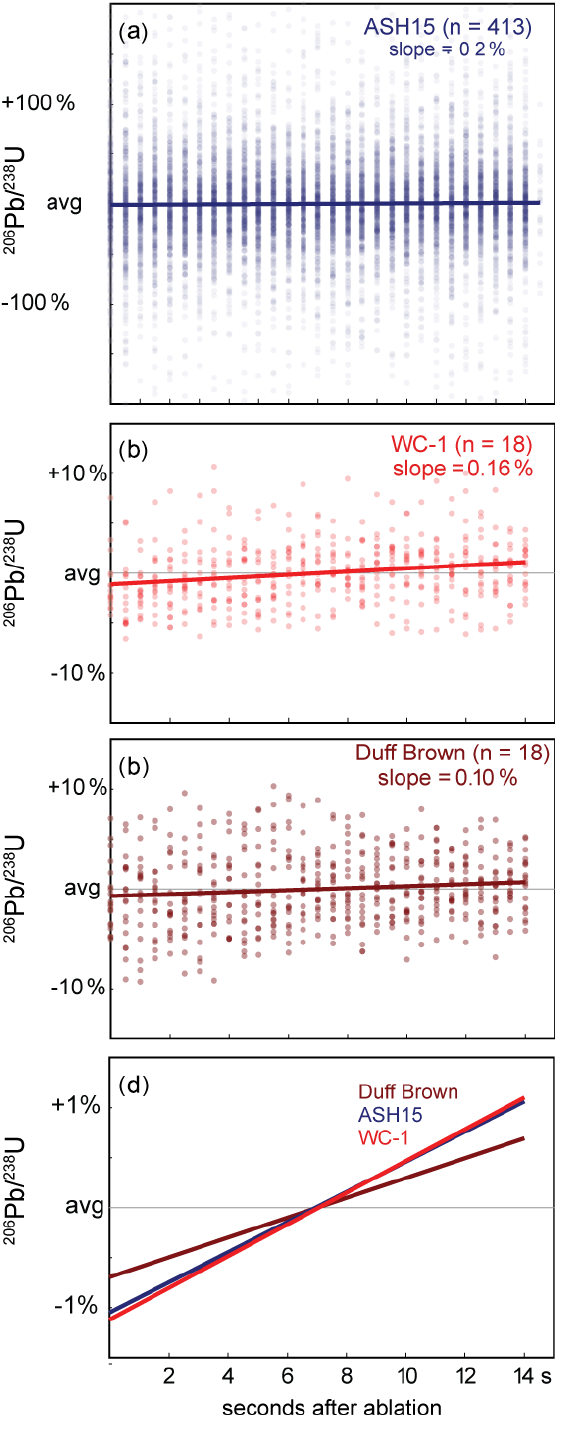
Figure 5. Stacked integration plots of raw 207 Pb-corrected 206 Pb / 238 U ratios for calcite reference materials ASH-15, WC-1, and Duff Brown Tank. The low Pb concentration in ASH-15 yields more scatter, but average slopes of all RMs are similar, with 1%– 2% change in age over 10s (100 pulses) of ablation. The results suggest minimal differences in down-hole fractionation of the dif- ferent RMs.